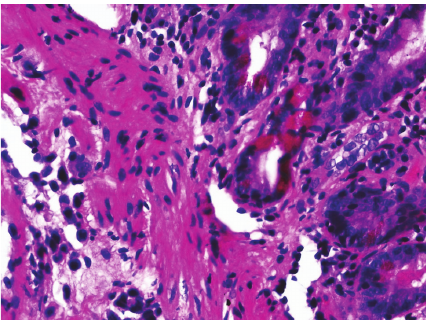
Figure 3: Duodenal biopsy with atypical cells in submucosal location, showing enlarged nuclei and nucleoli, with partial plasma- cytoidmorphology.Thesecellswerepresentedinasinglecellpattern (H&E, × 400).